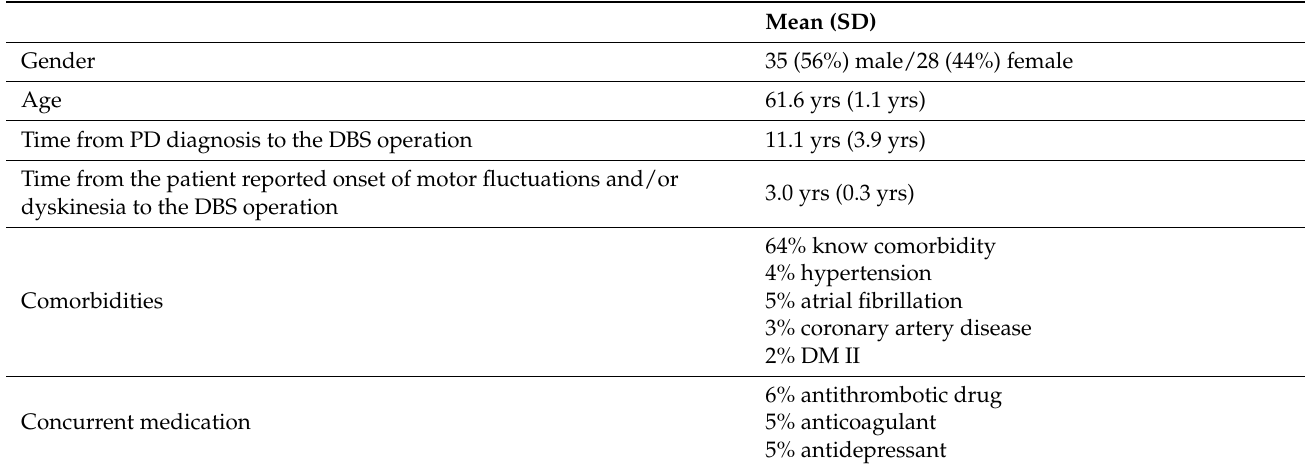
Table 1. The demographics of the patients.